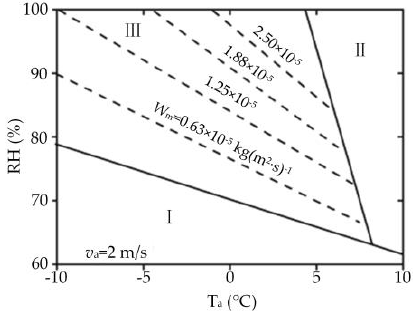
Figure 7. Frosting map proposed by Wang and Chen [70].